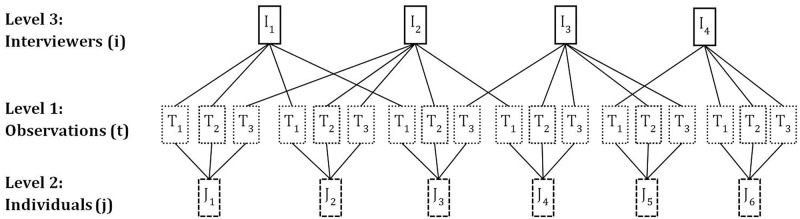
Example of multiple-membership three-level hierarchical data structure.